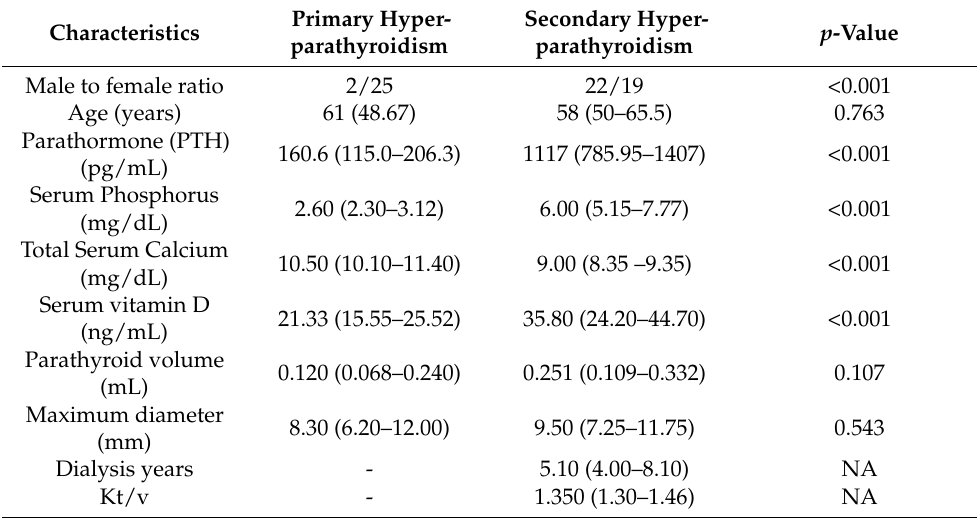
Table 1. Baseline characteristics of the studied subgroups.